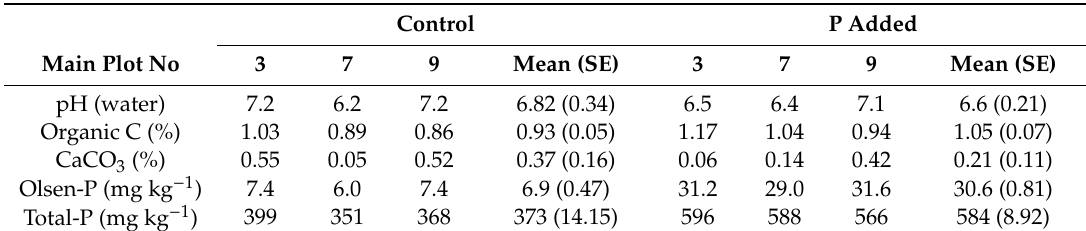
Table 3. General characteristics of the 0–23 cm soils of the six plots sampled of the Exhaustion Land Experiment. Control P